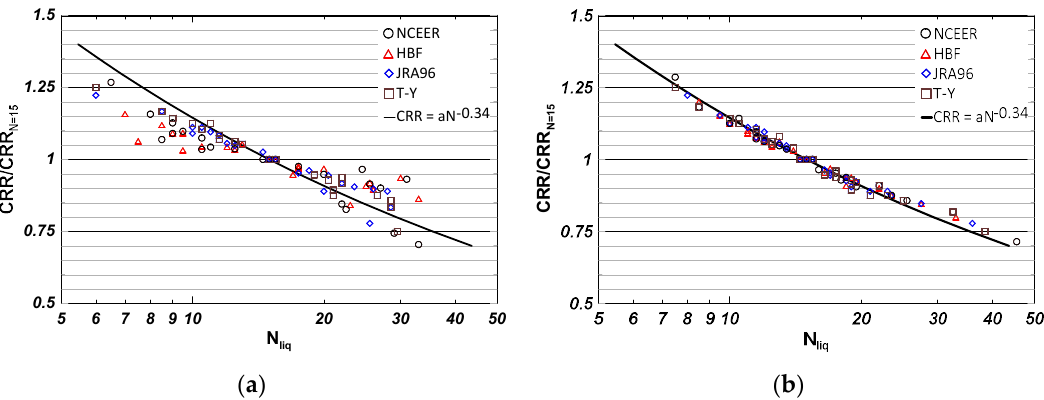
Figure 6. Weighting curves of four simplified liquefaction analysis procedures. ( a ) Finn model; ( b ) UBCSAND model.